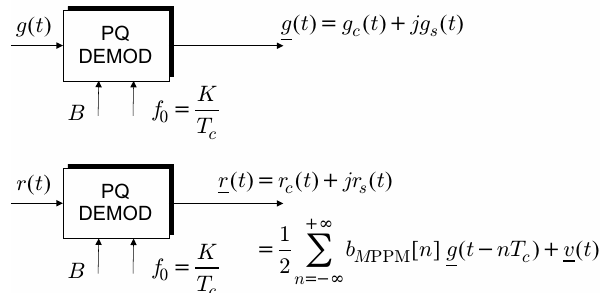
Figure A5. Low-pass signal representation of M PPM